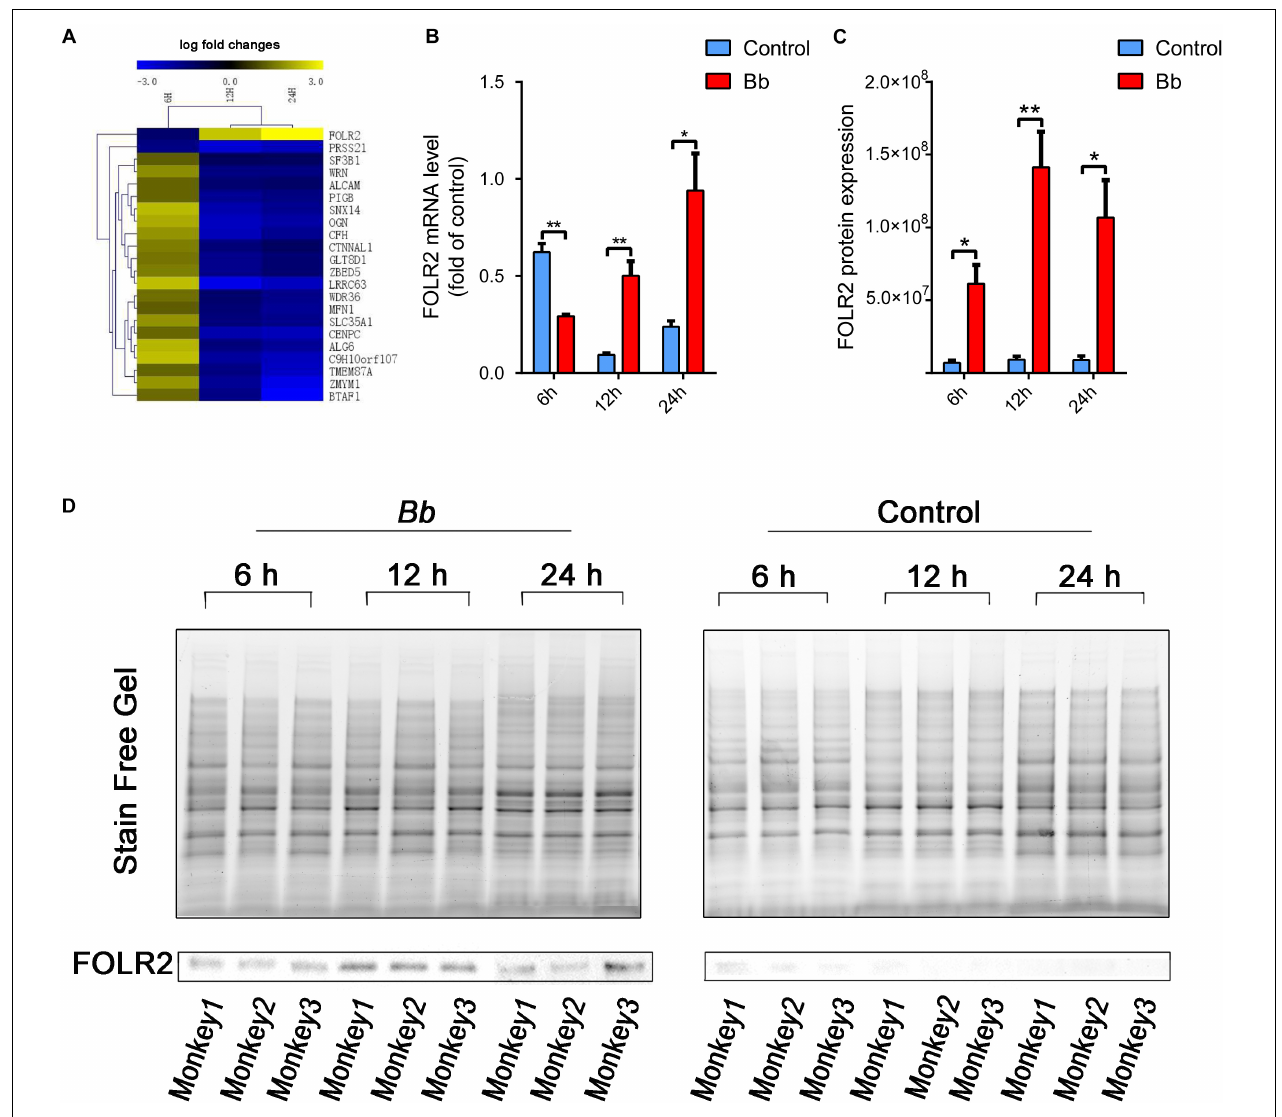
FIGURE 7 | Significant alteration of FOLR2 expression during the progressions of Bb infection. (A) Heatmap showing the fold changes of DEGs based on RNA-seq datasets at three time points in the frontal cortex co-cultured with live Bb compared with the control. Upregulated and downregulated genes are shown in yellow and blue, respectively. (B) Real-time PCR analysis of FOLR2 expression comparing explants from the frontal cortex of rhesus brains co-cultured with live Bb with the controls at 6, 12, and 24 h. (C) Protein expression of FOLR2 in explants from the frontal cortex of rhesus brains co-cultured with live Bb and the controls at 6, 12, and 24 h, validated by western blotting. (D) Western blotting results using total protein loading in the stain-free gel as a loading control. ∗ p < 0.05, ∗∗ p < 0.01, Bb vs. Control, analyzed with an unpaired two-tail Student t -test. Data were expressed as the means ± SEM.